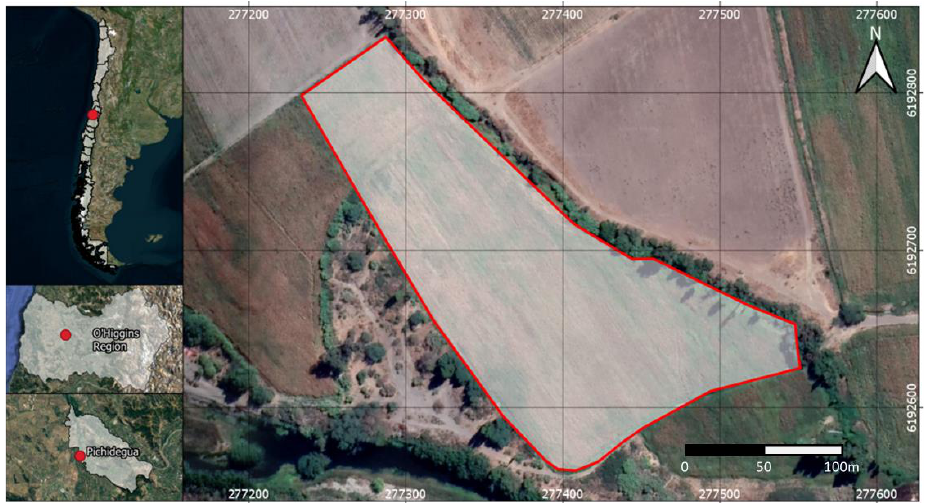
Figure 1. Location map of San Luis (277399 E° 6192699 S), experimental site (Google Earth, datum WSG 1984).